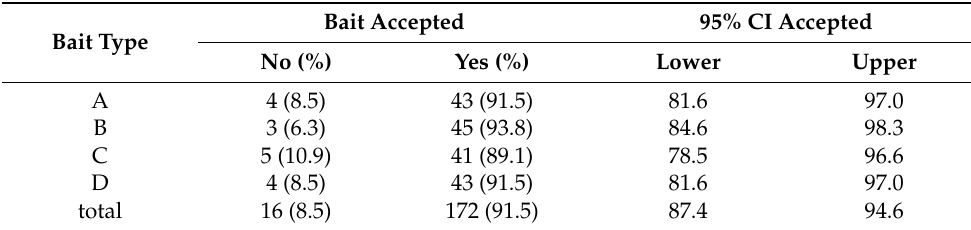
Table 2. Overall bait acceptance according to bait type.